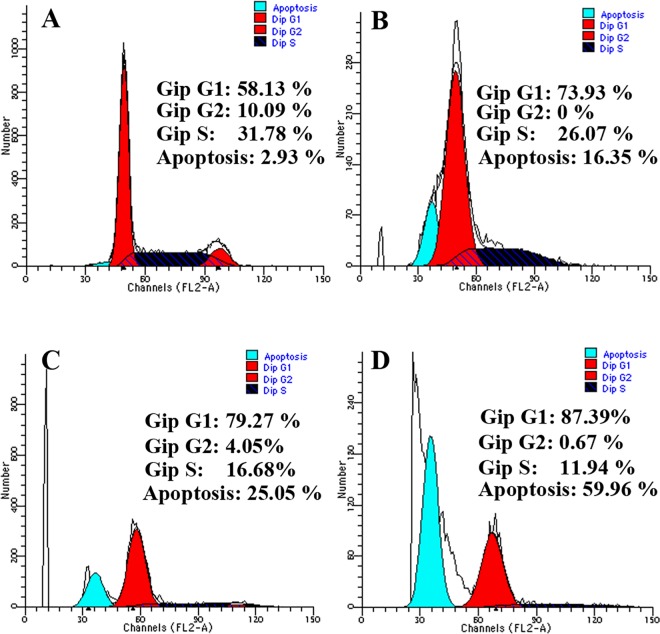
HPRP-A2 triggered cell cycle arrest.Cell-cycle distributions after treatment with 5, 10 and 15 μΜ HPRP-A2 for 24 h separately were detected by flow cytometry. Cell-cycle distributions were assessed by PI staining. The results were showed from one of three experiments with similar results.